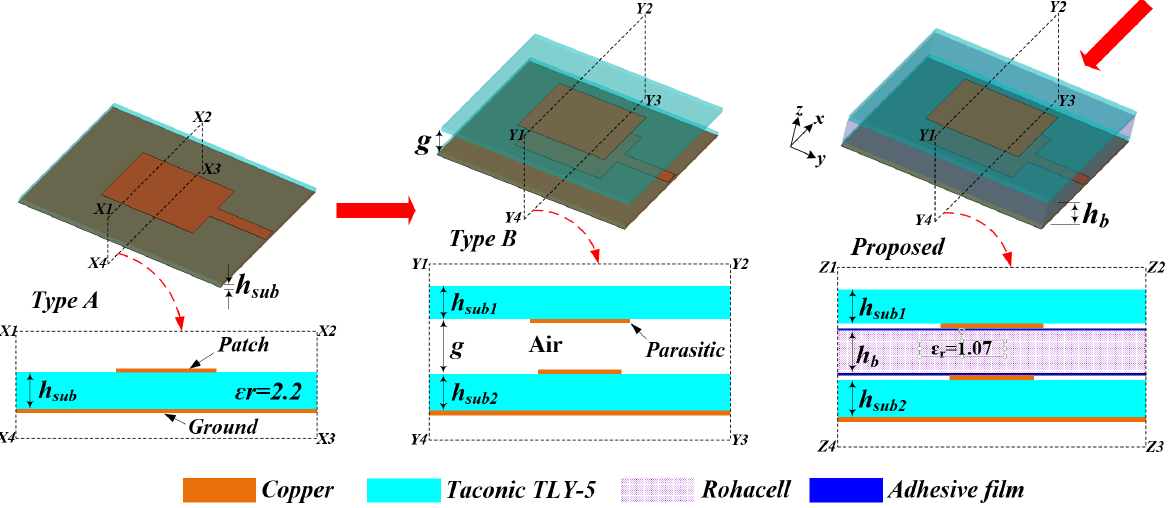
Figure 2. Three different types of radiating elements. (h sub1 = 0.508 mm, h sub2 = 0.508 mm, h b = 2.5 mm, H air = 2.536 mm, and adhesive film thickness = 0.2 mm).